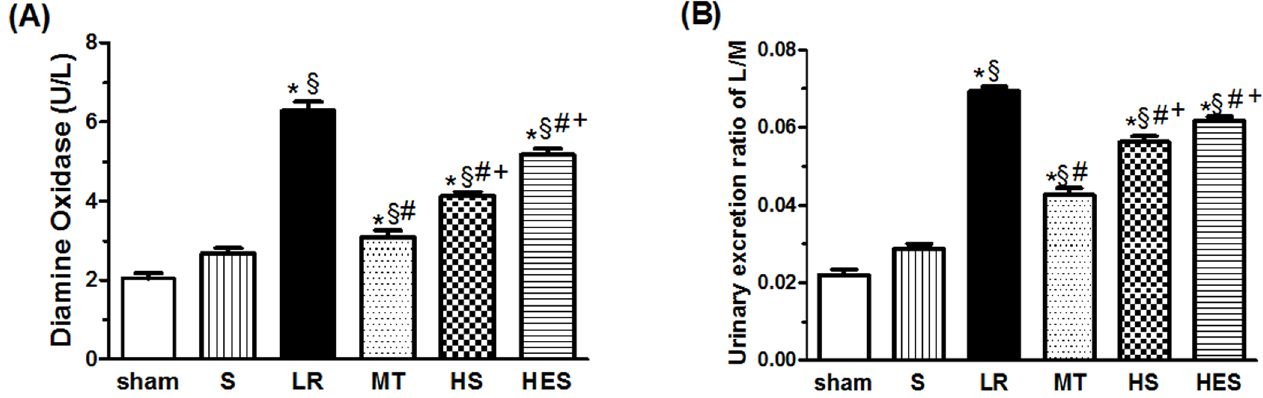
Fig 5. Levels of intestinal diamine oxidase (DAO) and urinary excretion ratio of the lactulose/mannitol (L/M). (A) Comparison of intestinal DAO between groups. (B) Comparison of L/M between groups. Data are presented as means ± S.E.M., n = 8 in each group. Data are presented as means ± S.E.M., n = 8 in each group. * P < 0.05 in comparison with the sham group, § P < 0.05 in comparison with the S group, # P < 0.05 in comparison with the LR group, + P < 0.05 in comparison with the MT